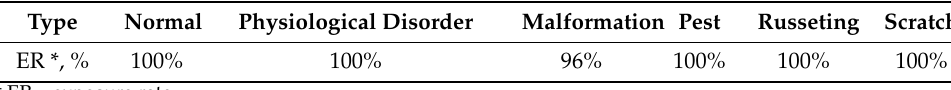
Table 2. Quantitative surface exposure rate for each type of apple.